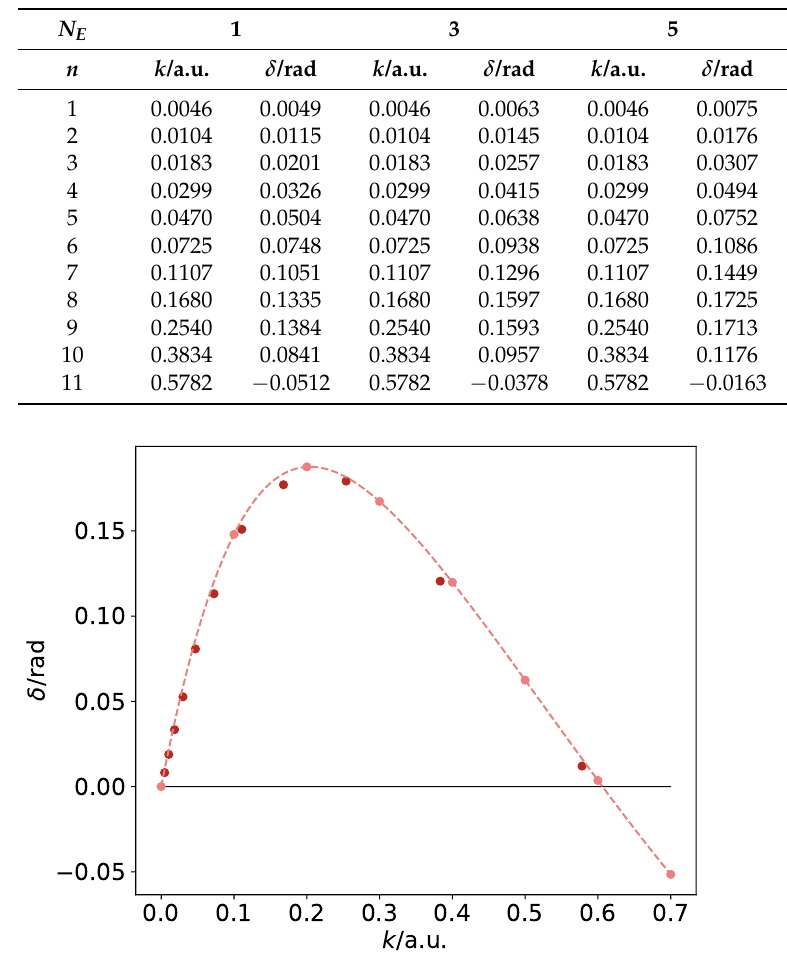
Table 1. Results from positron–hydrogen s -wave phase shift calculations with wavefunctions con- taining N E = 1,3,5 and 9 terms with nonzero γ i to describe electron–positron correlations (see Appendix B). Phase shift values are shown for the first 11 eigenvalues E n .